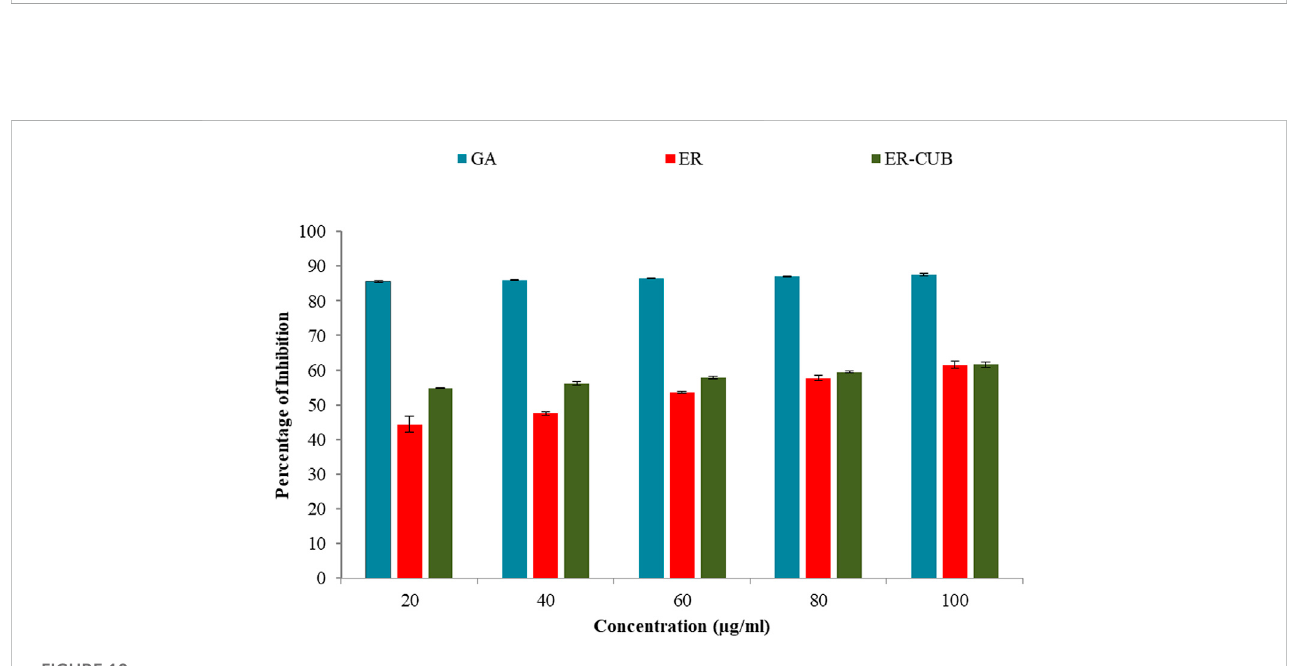
FIGURE 10 Antioxidant potential of different concentrations of ER and ER-CUB.